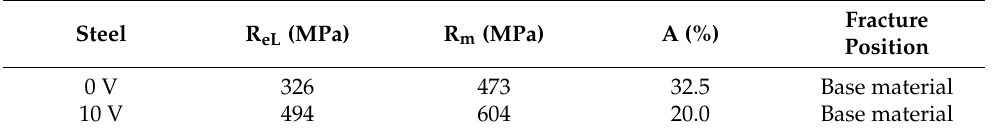
Table 5. Mechanical property of the welded joints.